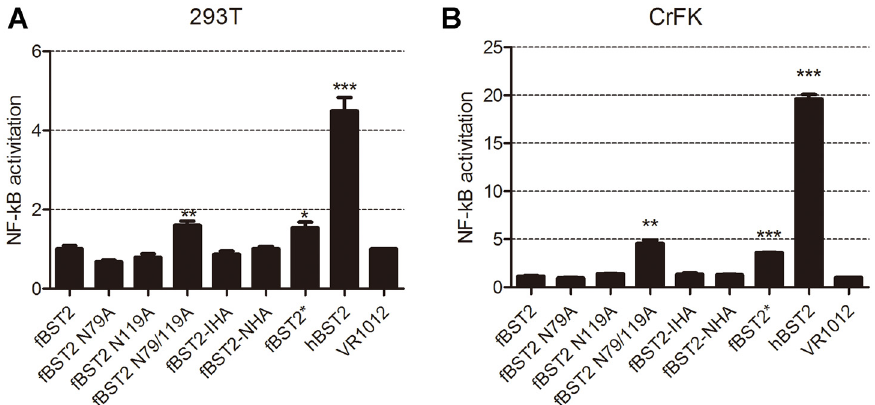
Fig 7. NF- κ B activation mediated by BST2 variants. (A and B) 293T and CrFK cells were co-transfected with 25 ng of each variant BST2 expression plasmids separately, along with 250 ng of pNF- κ B-Luc reporter plasmid and 50 ng Renilla luciferase plasmid. After 48 h, cells were lysed and analyzed for luciferase activity. The raw luciferase value was normalized to the Renilla luciferase value. Data are shown as fold changes in NF- κ B activation compared with the mock control. The graph was generated from three independent experiments. * P < 0.05; ** P < 0.01; *** P < 0.001 compared to